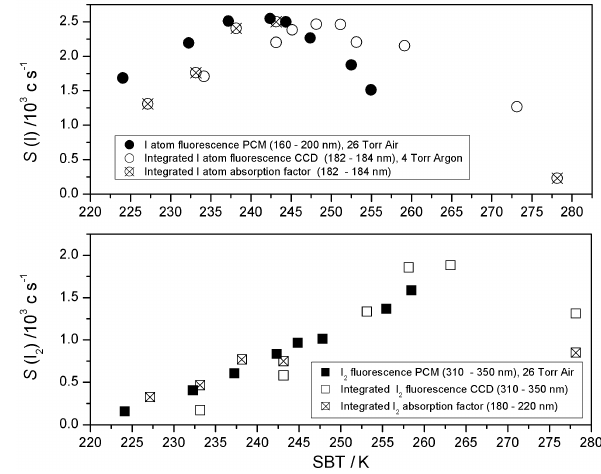
Fig. 3. Fluorescence signal dependence on side branch temperature, SBT (i.e. iodine vapour pressure). Upper panel: I atom fluorescence S (I) registered by photon counting in the range 160–200nm (filled circles), integrated dispersed fluorescence of the 183.083nm I atom line from a spectrograph-CCD recording (empty circles), and I atom absorption factor (crossed circles). Bottom panel: the same for off- resonance I 2 fluorescence at the corresponding spectral range. S (I) and S (I 2 ) correspond to mixing ratios of 2.5 and 4.8ppbv in the cali- bration flow tube. Integrated dispersion fluorescence and absorption factors have been scaled by an arbitrary